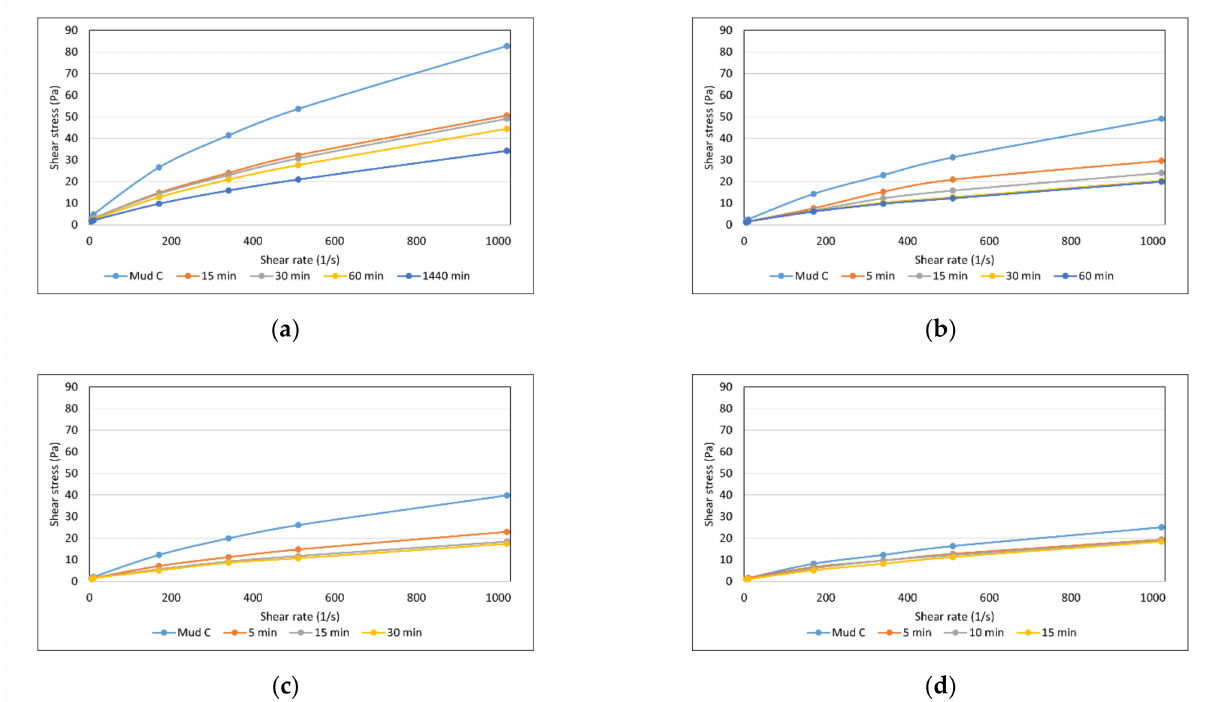
Figure 9. Flow curves of drilling mud C with 1.0% calcium hypochlorite: ( a ) at a temperature of 20 ◦ C, ( b ) at a temperature of 40 ◦ C, ( c ) at a temperature of 60 ◦ C, ( d ) at a temperature of 80 ◦